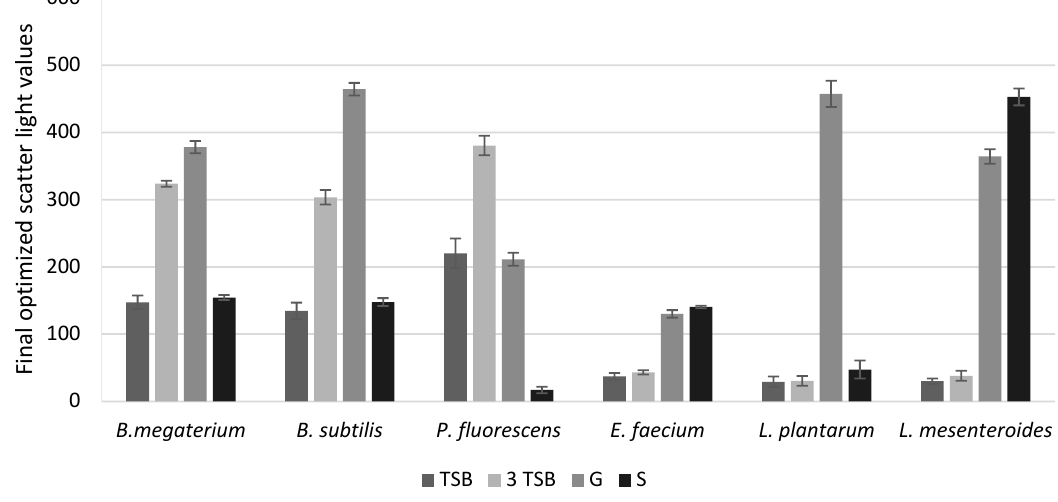
Figure 1. Final scatter light values for standard media and media optimized on the basis of Tauguchi experiments. TSB—reference/control medium in the concentration recommended by the manufacturer; 3TSB—reference medium in concentration three times higher than what is recommended by the manufacturer; G—variant of the optimization of the medium containing glucose; S—variant of the optimization of the medium containing sucrose.